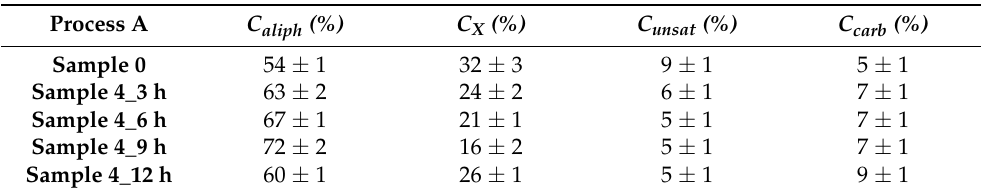
Table 3 . Integral values, in percentage, of C aliph , C X , C unsat , and C carb , calculated for Sample of process A and comparison with Sample 0.